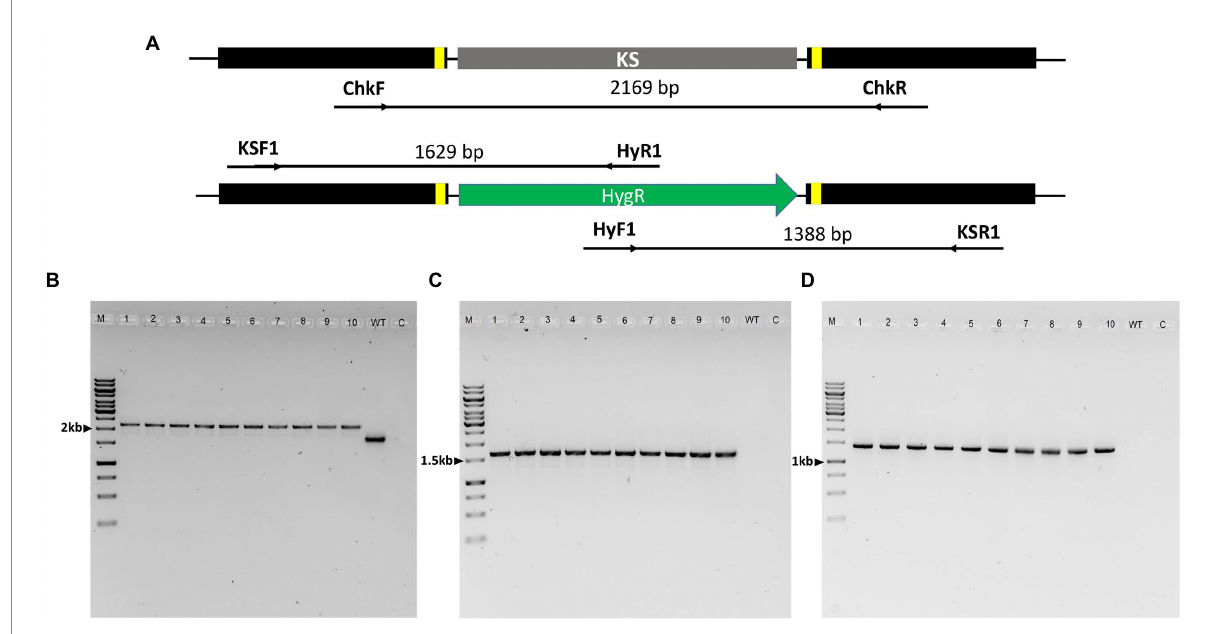
FIGURE 5 PCR analysis of Lophiotrema sp. F6932 Δ PAL KS deletion mutants. (A) An overview of the PAL KS domain locus in the wild-type strain and integration of HygR after CRISPR-Cas9 RNP-mediated deletion of the KS domain; (B) PCR amplification of HDR-HygR repair template integration locus spanning the cleavage sites of Cas9-RNPs complexes using ChkF/ChkR primer set showing the expected 2,169 bp and 1,664 bp bands in the mutants and wild-type strain, respectively; (C) PCR amplification of the deletion mutants and wild-type strain using primer sets KSF1/HyR1 and (D) HyF1/KSR1. M = 1 kb DNA ladder, 1–10 = Δ PAL KS deletion mutants resistant to hygromycin B, WT = wild-type strain, and C = Control. The full- length gel pictures are shown in Supplementary Figures